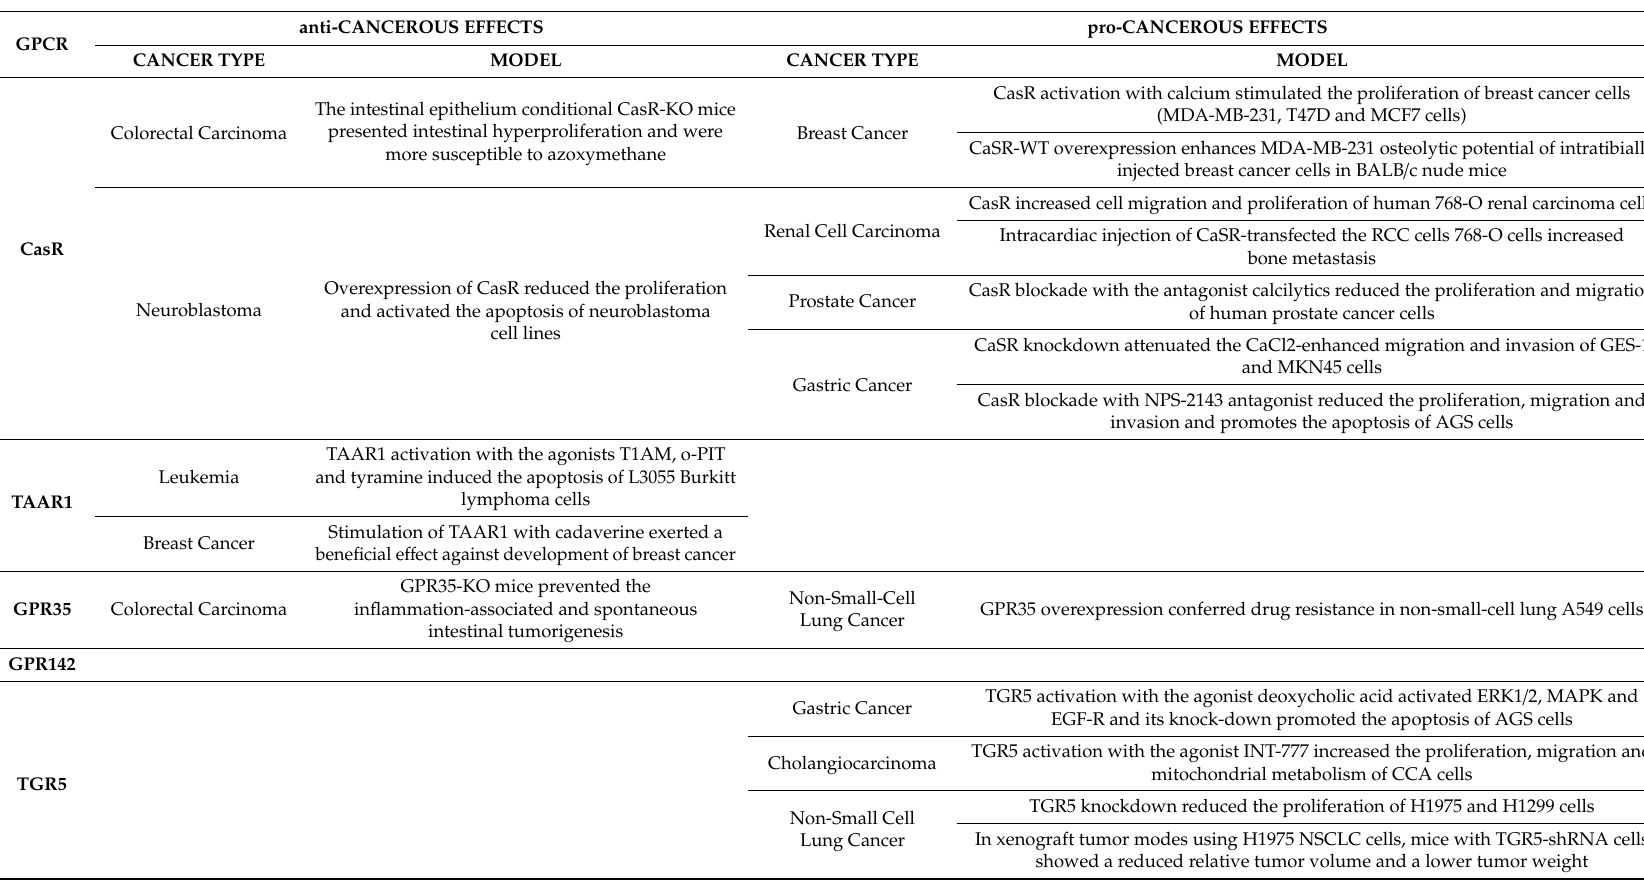
Table 5. Functional studies performed describing the role of the amino acid, amino acid-related metabolites and bile acid sensing receptors in several types of cancers. This table includes the literature which demonstrates the anti-cancerous and pro-cancerous role of each amino acid, amino acid-related metabolites and bile acid sensing receptor in both in vitro cells or in vivo with mice. (CasR, calcium sensing receptor; TAAR1, trace amine associated receptor